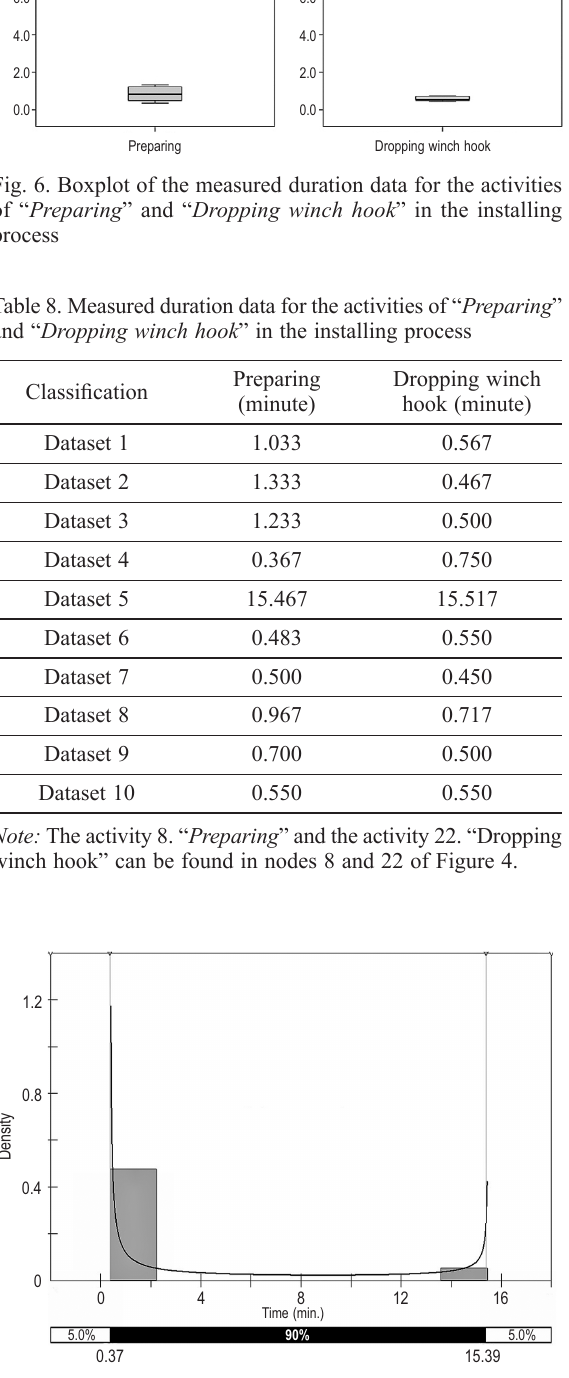
Dropping winch hookPreparing